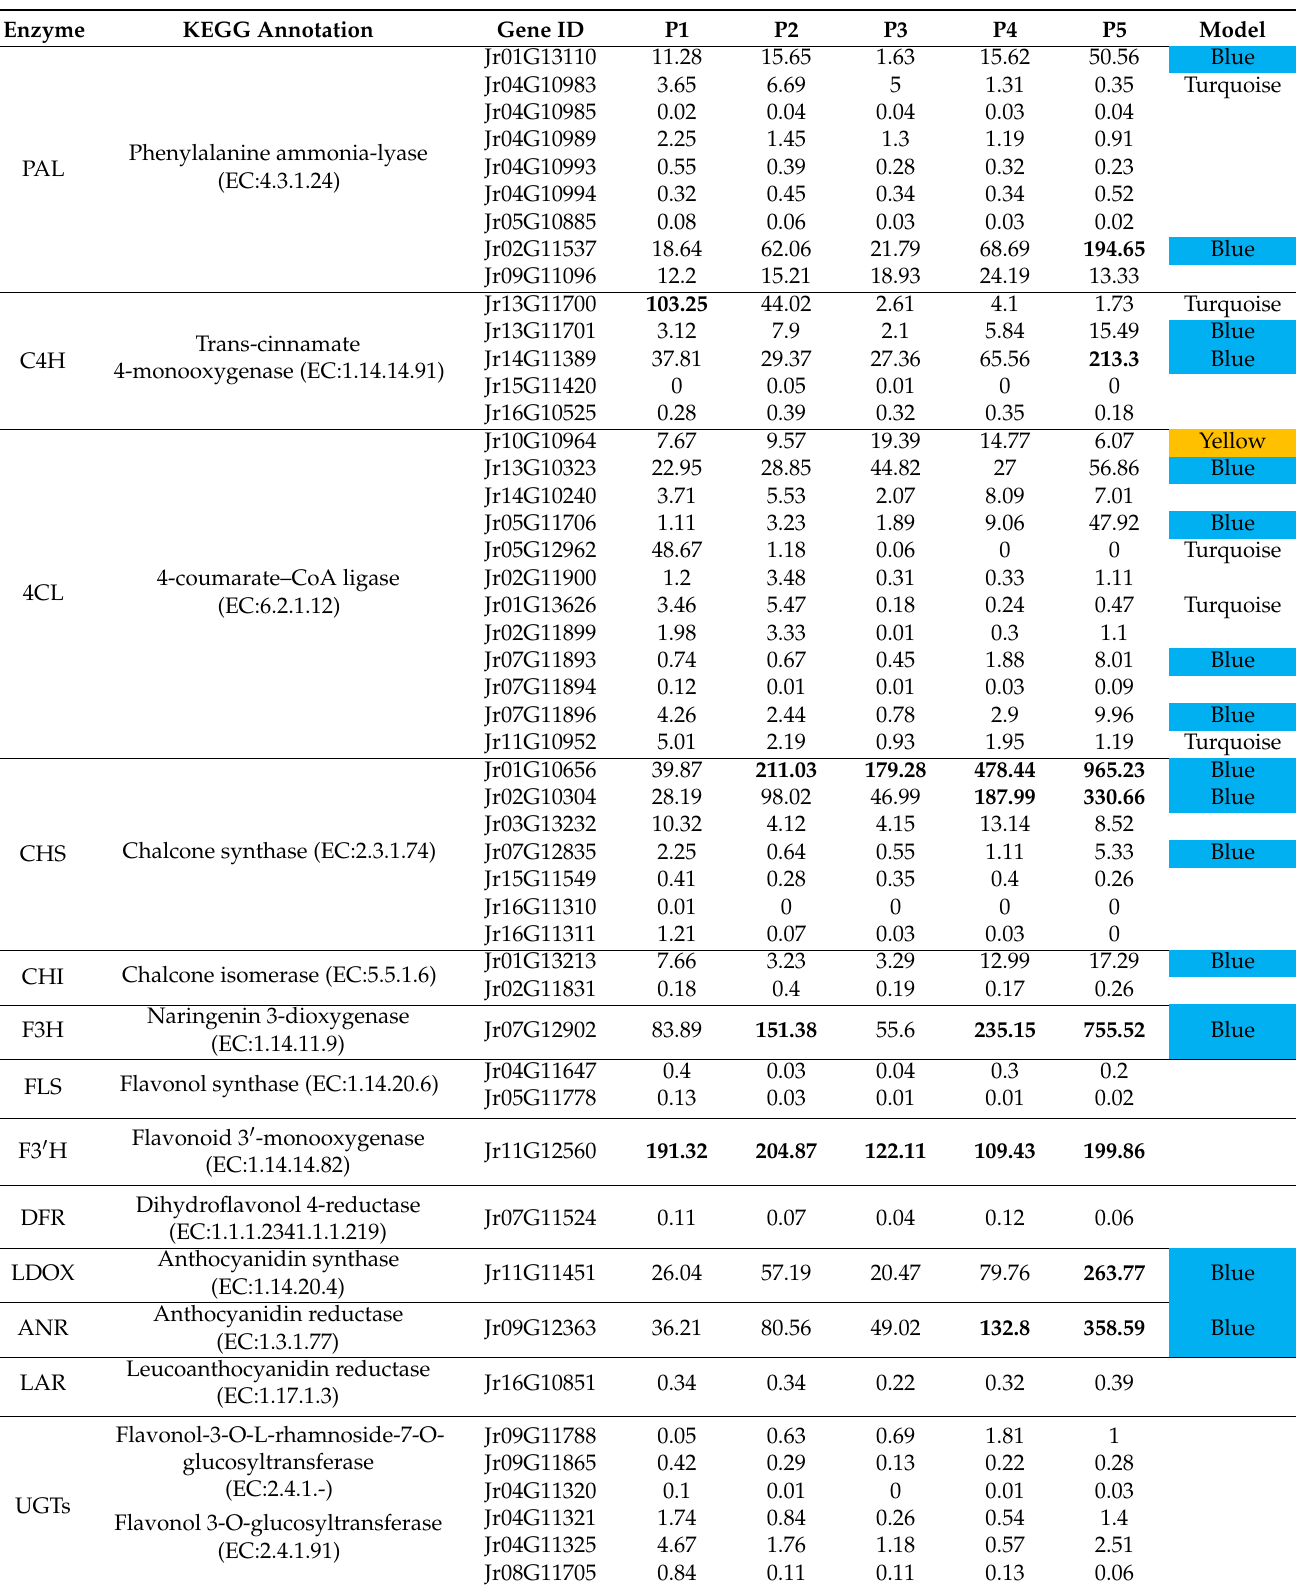
Table 3. Identification of genes involved in polyphenol synthesis. The expressed unigenes with FPKM values > 100 are highlighted with bold font. The three color modules are from Figure 5. “Jr” in the gene ID is an abbreviation of